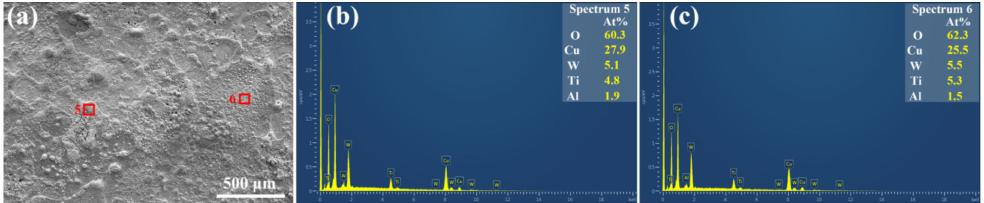
Figure 7. ( a ) SEM morphology of the eroded Cu-Ti 3 AlC 2 surface by 100 times arc discharging; EDS results in ( b ) and ( c ) corresponding to the rectangles 5 and 6 in ( a ),